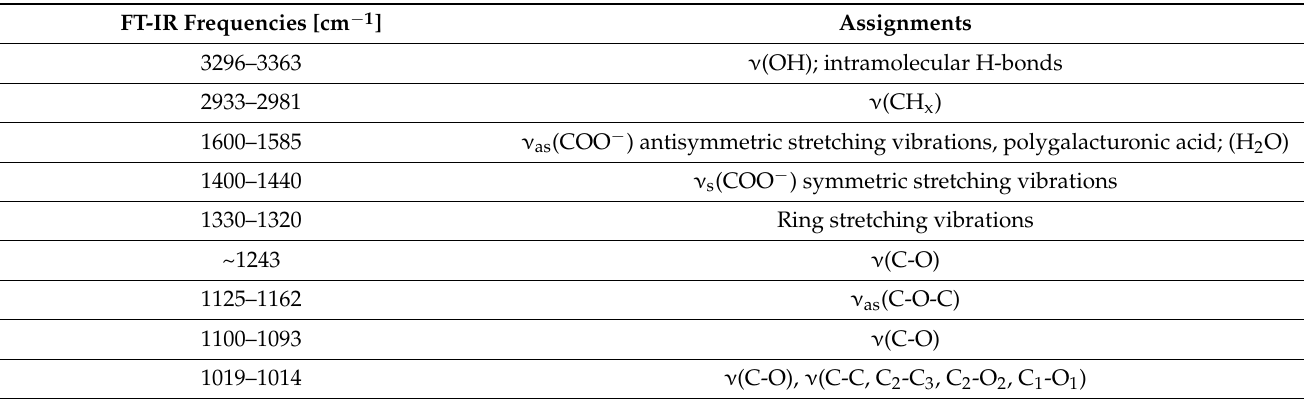
Table 1. Selected infrared bands with